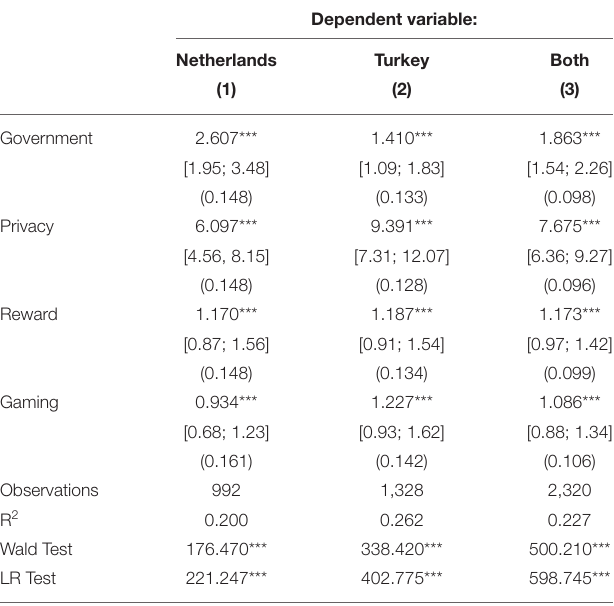
TABLE 4 | Regression results.